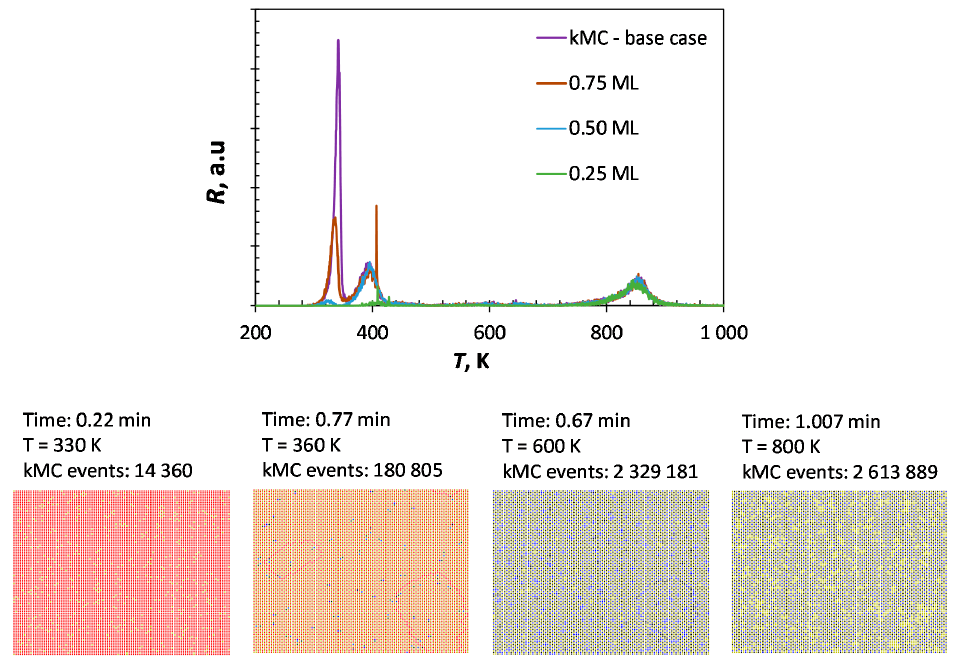
Figure 5. Simulated CO-TPD (heating rate: 10 K·s − 1 ) obtained using kMC (top) and the surface coverage at various temperatures for Θ CO,initial = 1.00 ML ( yellow : vacancy, red : CO, black : C, blue : O).